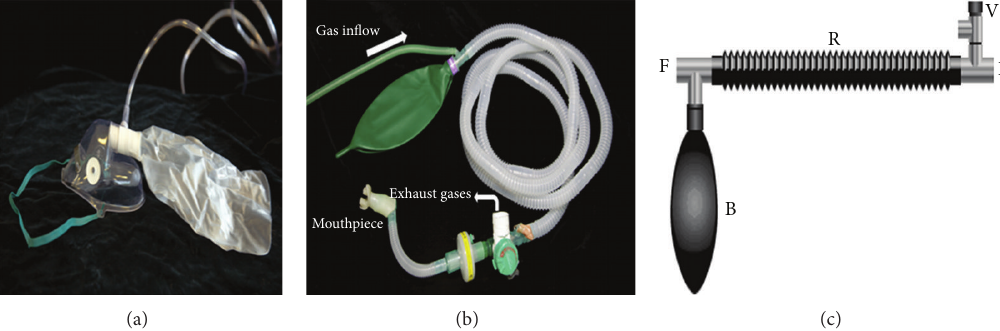
Figure 1: (a) Hudson mask with oxygen tubing. (b) Mapleson A semi-open circuit with mouthpiece (exhaust tubing removed for clarity). (c) Schematic diagram of Mapleson A circuit: 3 way T-tube connected to the fresh gas outlet (F), a breathing bag (B), and a reservoir tube (R). Reservoir tube is connected to the patient (P) and a spring-loaded expiratory valve (V) (image courtesy of Anaesthesia UK (http://www.frca.co.uk/).